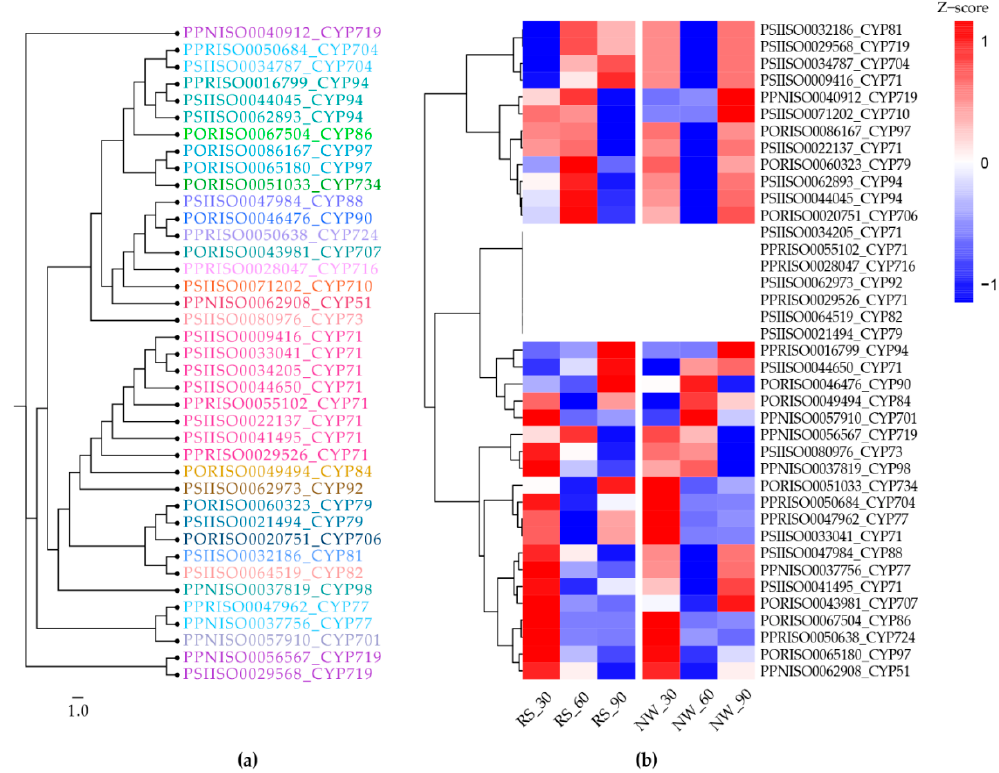
Figure 10. Cytochrome similarity and expression profile: ( a ) phylogenetic tree for the 39 full-length cytochromes; and ( b ) the corresponding expression profiles for 39 cytochromes. This tree was re-constructed from 1000 bootstrap trees.